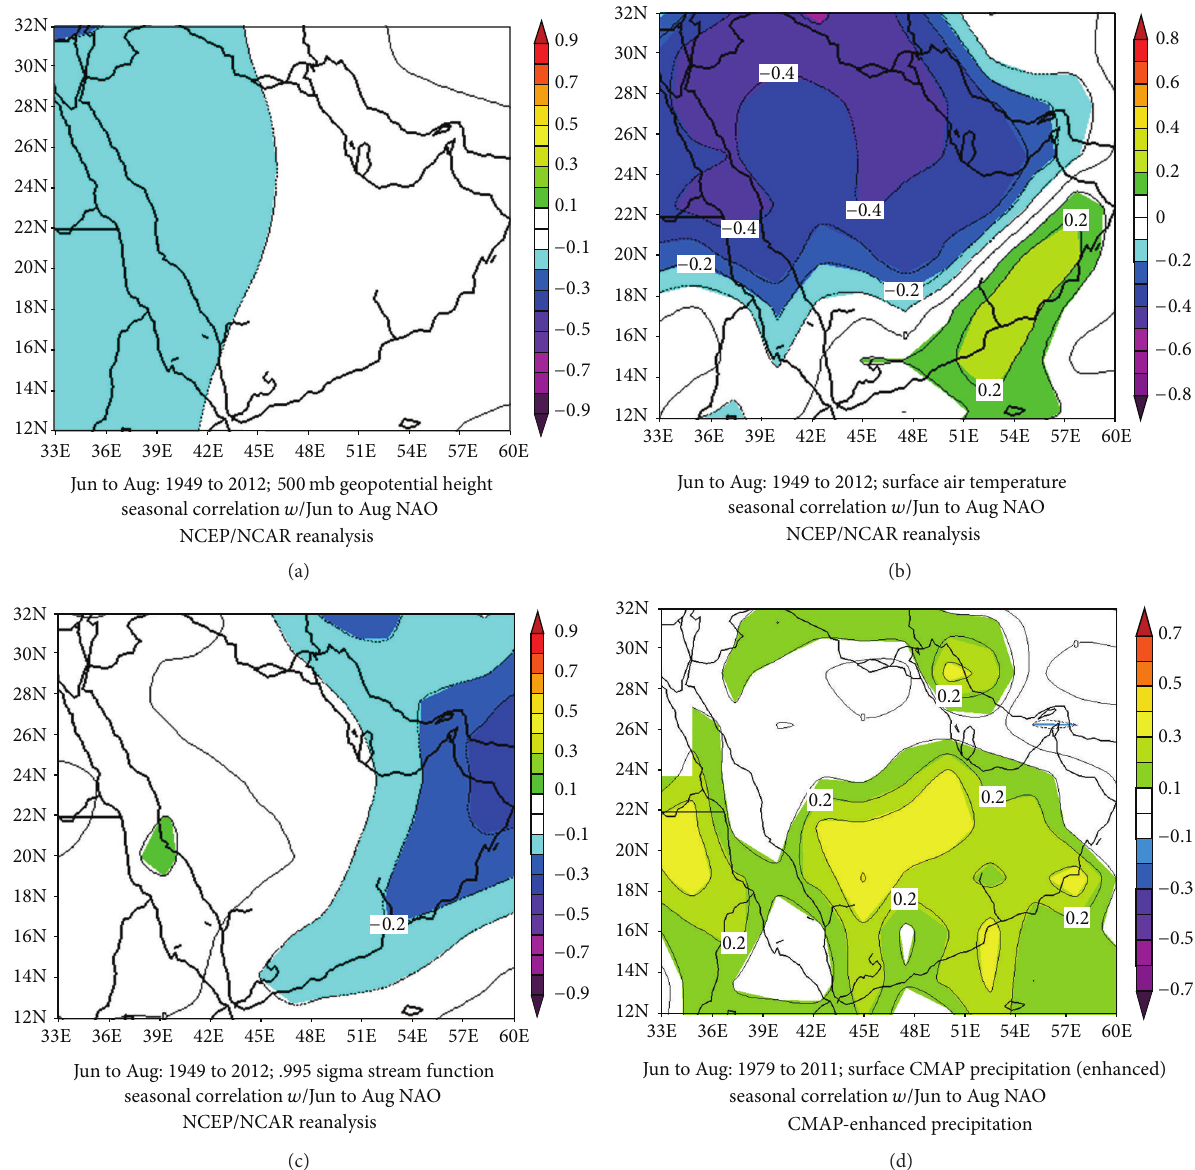
Figure 3: The distribution of the linear correlation coefficient between weather elements over KSA and NAO through the period of study.